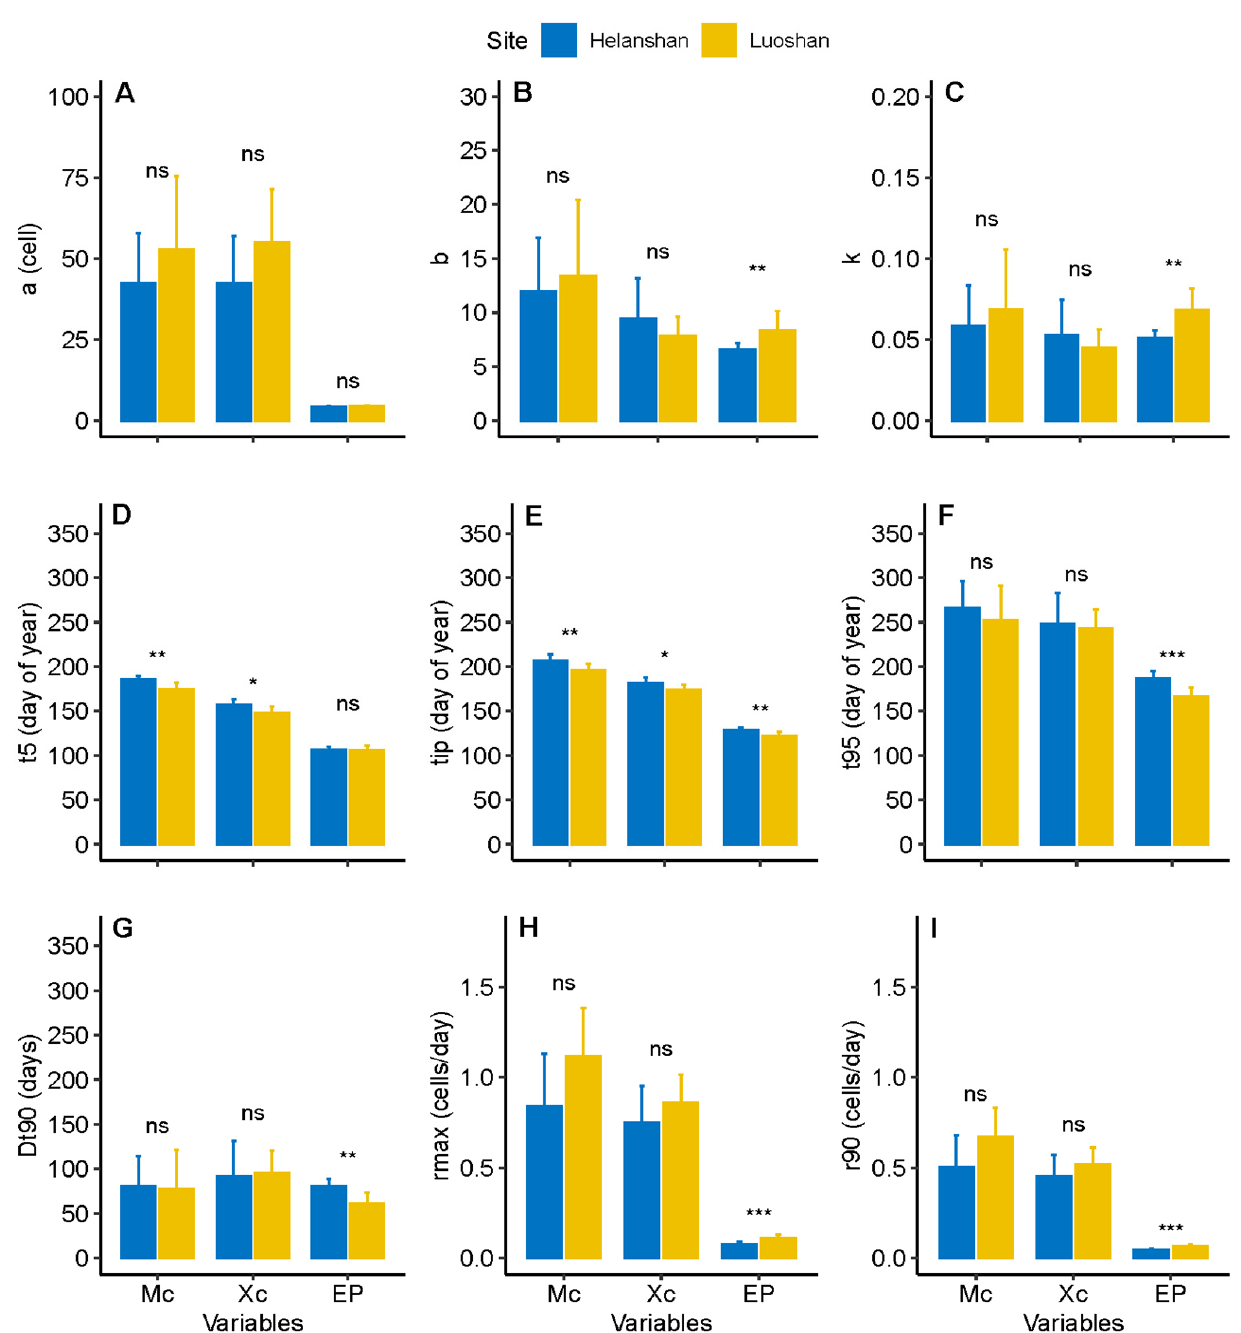
Figure 5. Biological parameters of xylem and phloem formation computed from Gompertz equations. Mc, Xc, and EP are the mature, total xylem, and early phloem cells, respectively. Parameter a ( A ) is the upper asymptote of the final number of cells; b ( B ) is the x-axis placement parameter reflecting the location of the origin; k ( C ) is the growth rate parameter determining the spread of the curve along the time axis; t5 ( D ) is the date at which 5% of the cells were produced; tip ( E ) is the date of the inflection point; t95 ( F ) is the date at which 95% of the cells were produced; Dt90 ( G ) is the duration between 5 and 95% of the produced cells; rmax ( H ) is the maximal growth rate and r90 ( I ) is the mean growth rate computed between 5 and 95% of the produced cells. Values are presented as mean ± SD. *, **, ***, and ns represent significant levels at p < 0.05, p < 0.01, p < 0.001, and p > 0.05,